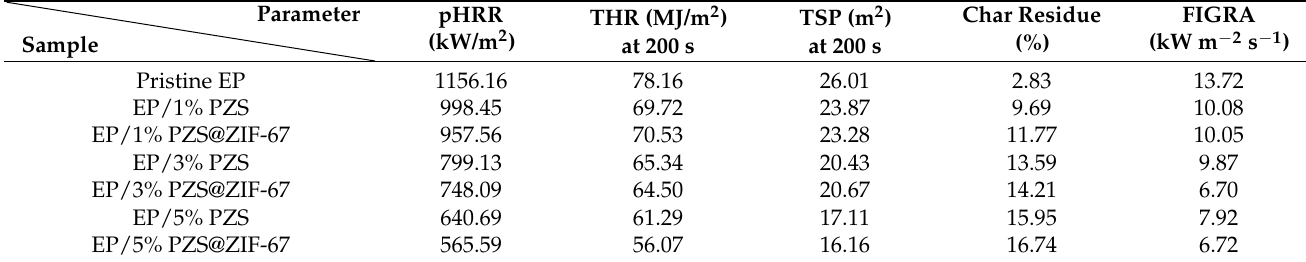
Table 5. Cone calorimeter data of pristine EP and its